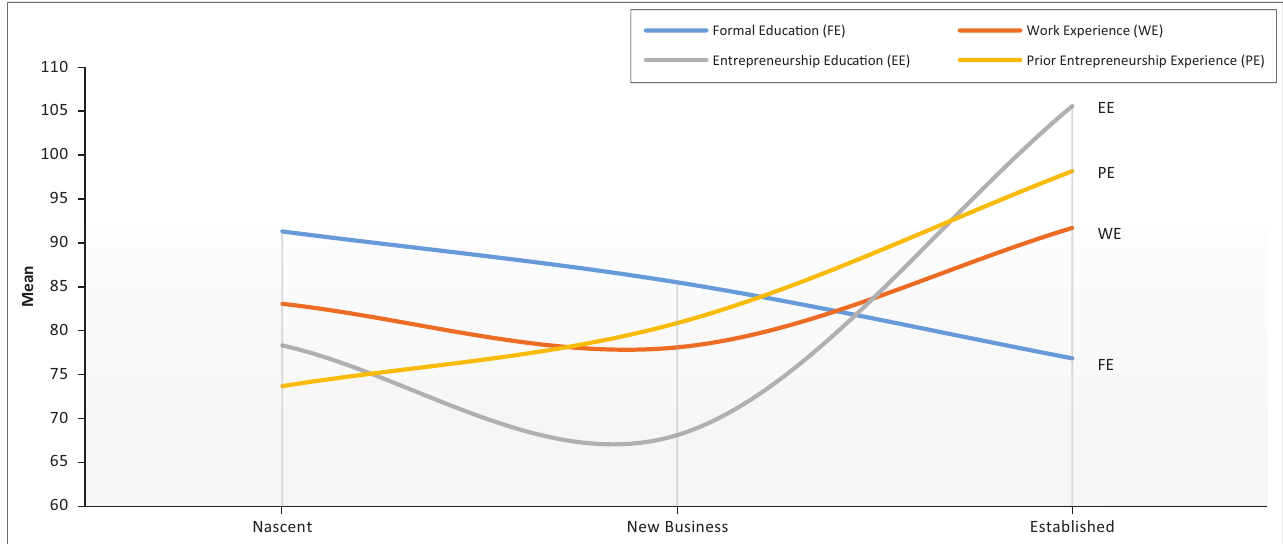
FIGURE 1: Human capital investments utility across the entrepreneurship